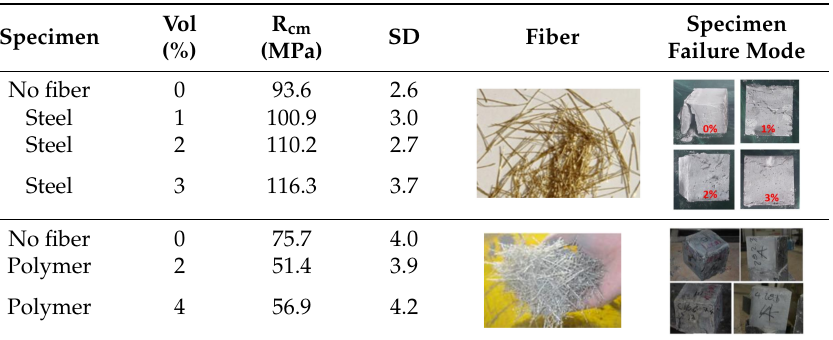
Table 1. Mean cube compressive strength (R cm ) for concrete with steel or polymer fibers considering different fiber volume fractions (Vol) and standard deviation (SD) of the compressive strengths after seven days of